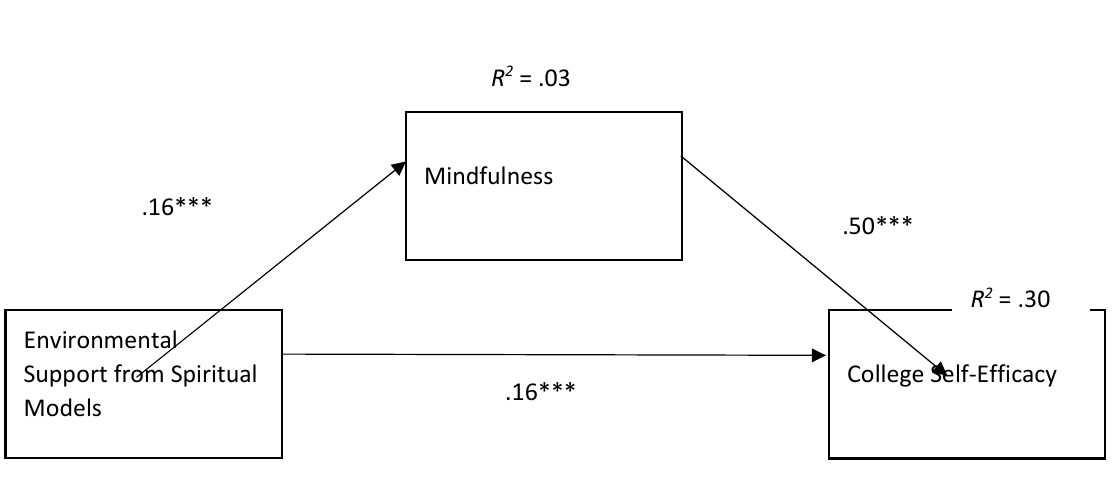
Figure 2. Mediation Path: Mindfulness. Note. ** = p ≤ .01, *** = p ≤ .001. Forgiveness as a mediator